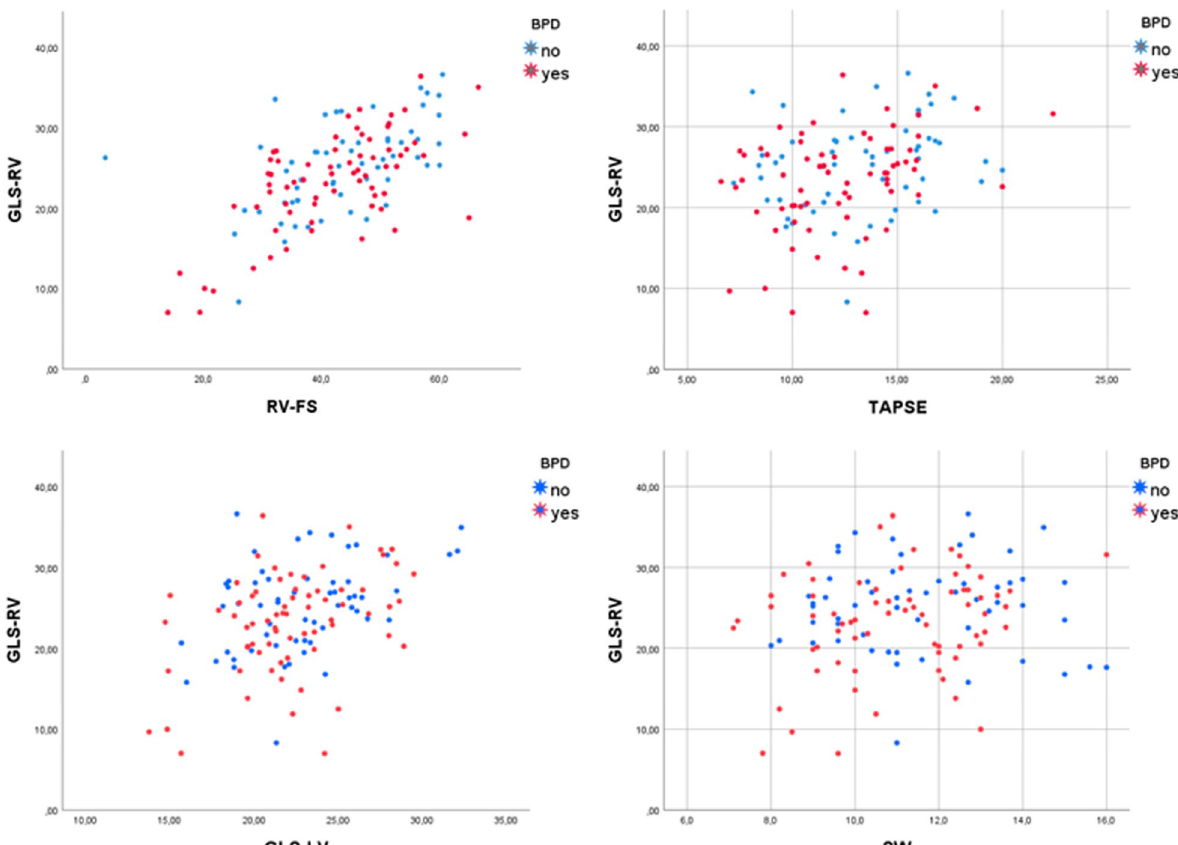
Fig. 2 Scatter plot relating GLS‑RV with RV‑FS, TAPSE, GLS‑LV and SW. It shows clear positive correlations between GLS‑RV and RV‑FS or GLS‑LV. There is a possible positive trend between GLS‑RV and TAPSE. No correlation is observed between GLS‑RV and